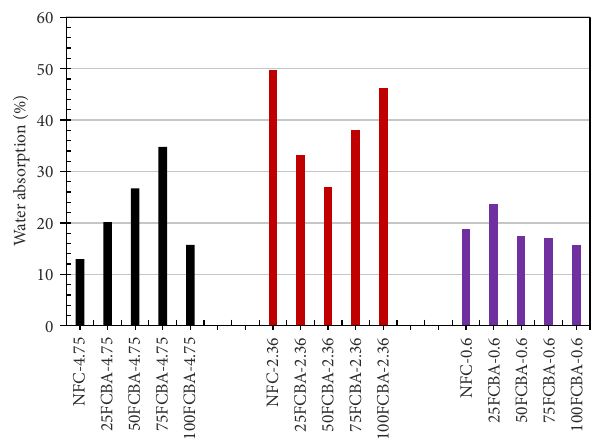
Figure 9. Variation in water absorption of LFC with CBA